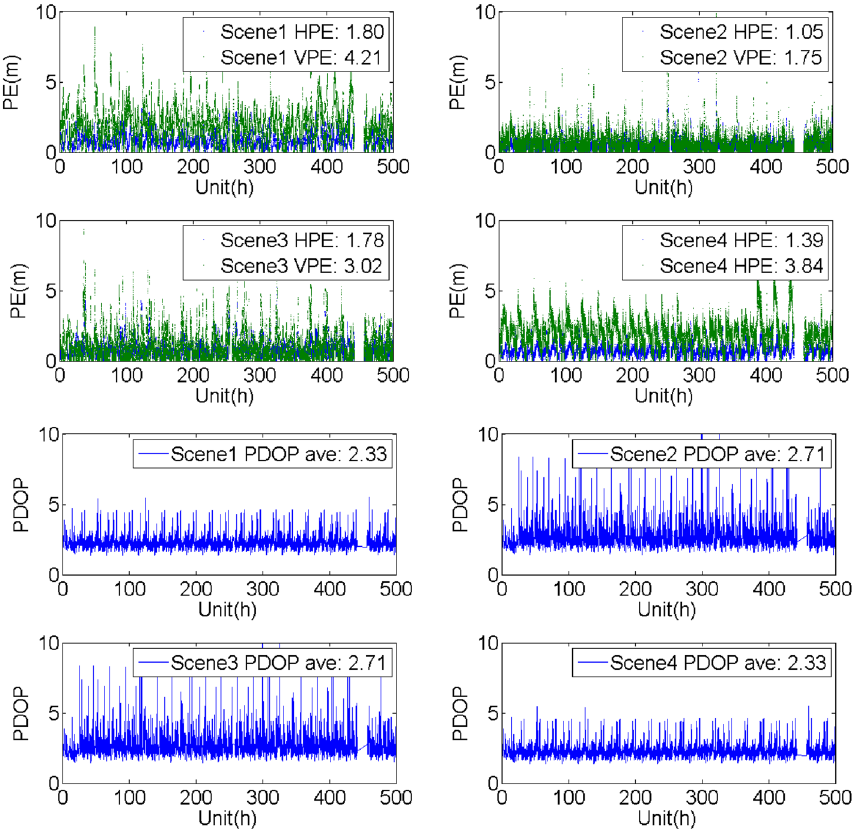
Figure 12. Evaluation of the PE and PDOP under different scenes in Harbin known point from Dec 11 to 31,